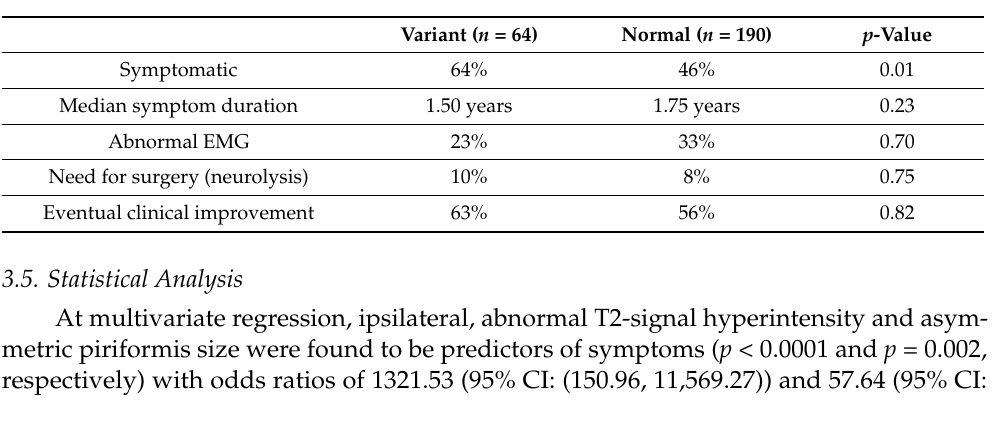
Table 5. Sciatic nerve type and correlation with clinical presentation and